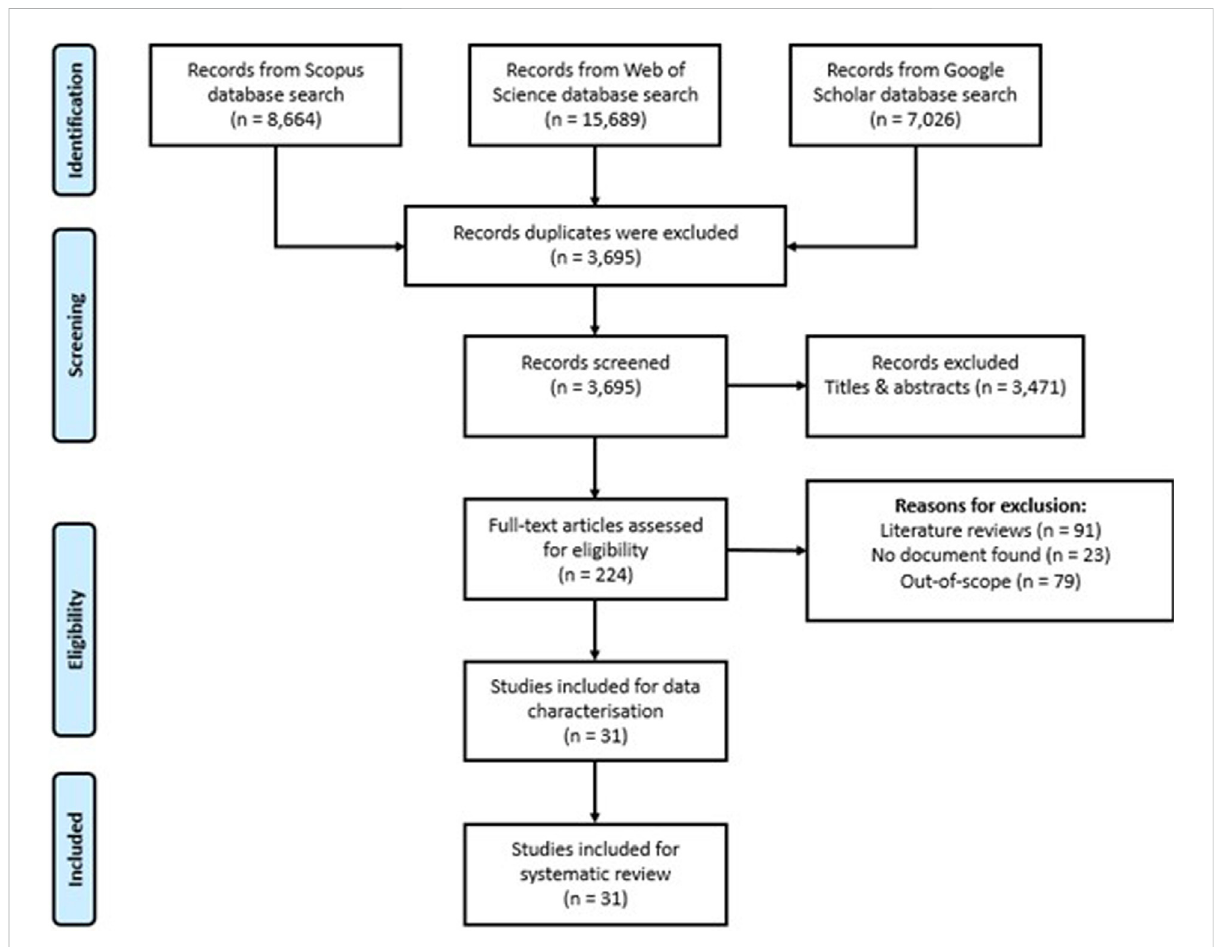
FIGURE 2 PRISM Flow Diagram of studies to be included in the systematic literature review. Source: Authors ’ diagram based on PRISMA guideline (Page et al.,